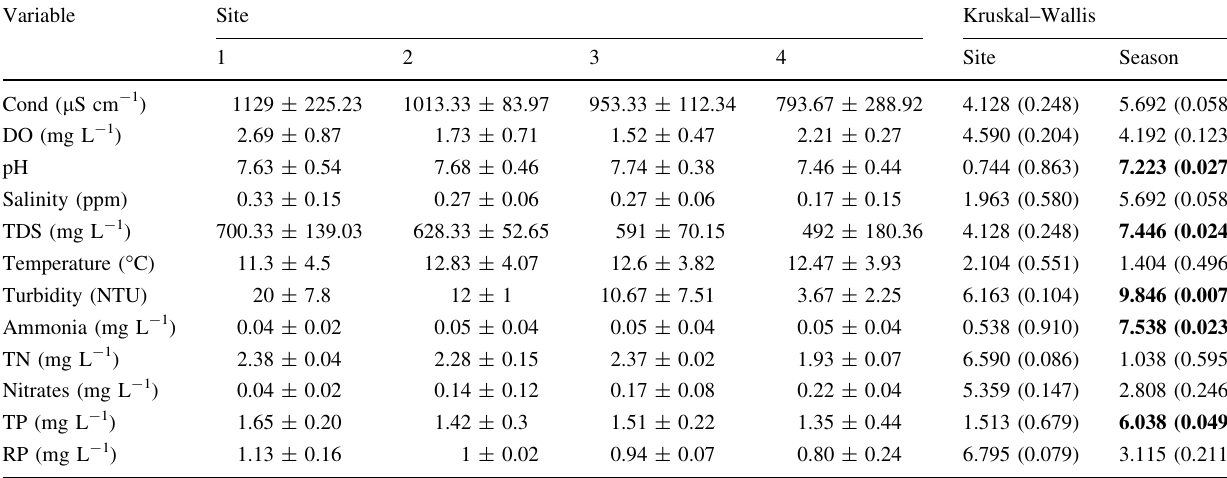
Table 1 Mean ( ± SD) summary of physical and chemical variables in the Ngamo River